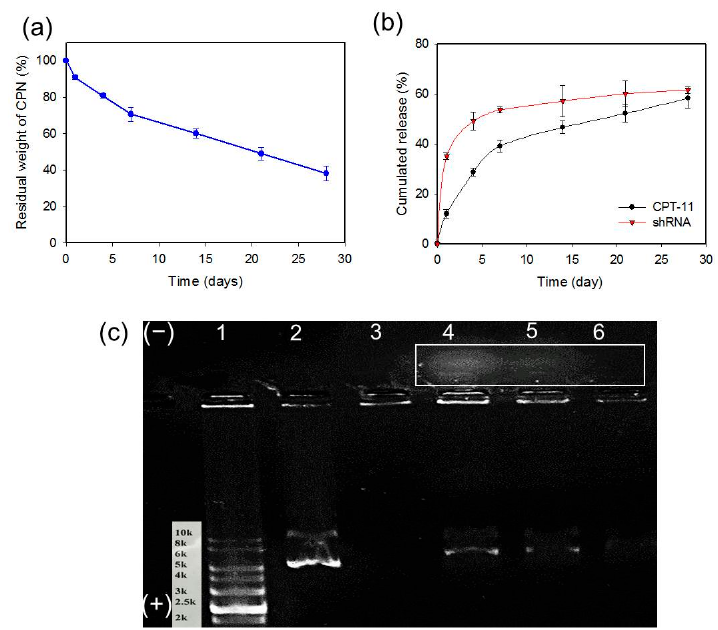
Figure 5. The degradation of CPN in pH 7.4 PBS at 37 °C ( a ) and the release of CPT-11 and SLP2 ( b ). ( c ) The agarose gel electrophoresis analysis of released shRNA. 1: marker; 2: shRNA; 3: release